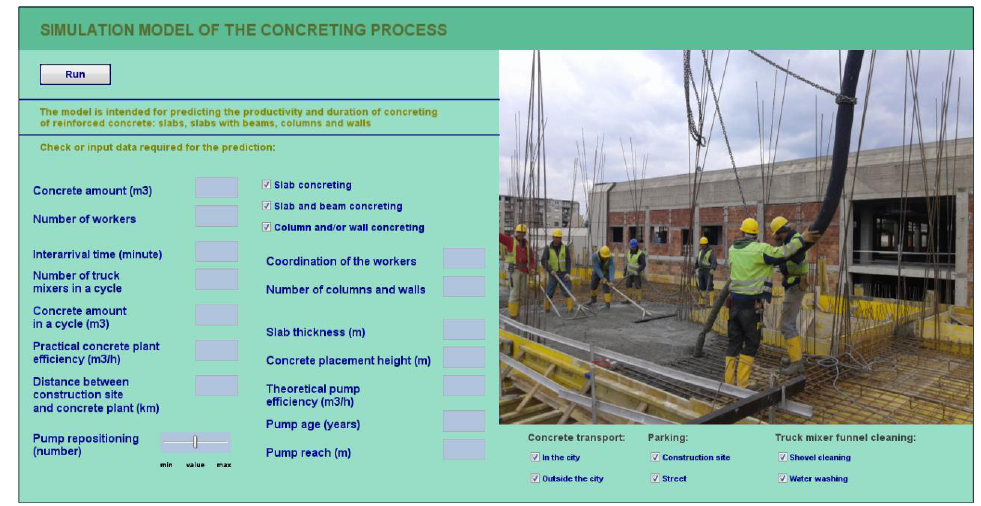
Figure 3. Definition of input parameters before running the simulation. The application provides different representations of the simulation model—logical (Figure 2) as well as 2D (Figure 4a) and 3D (Figure 4b).